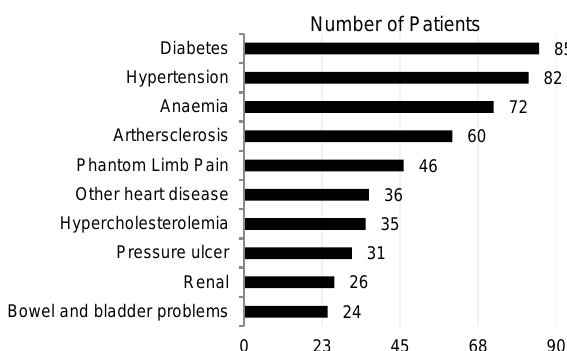
FIGURE 1 : Top 10 most common co-morbidities/secondary health conditions.